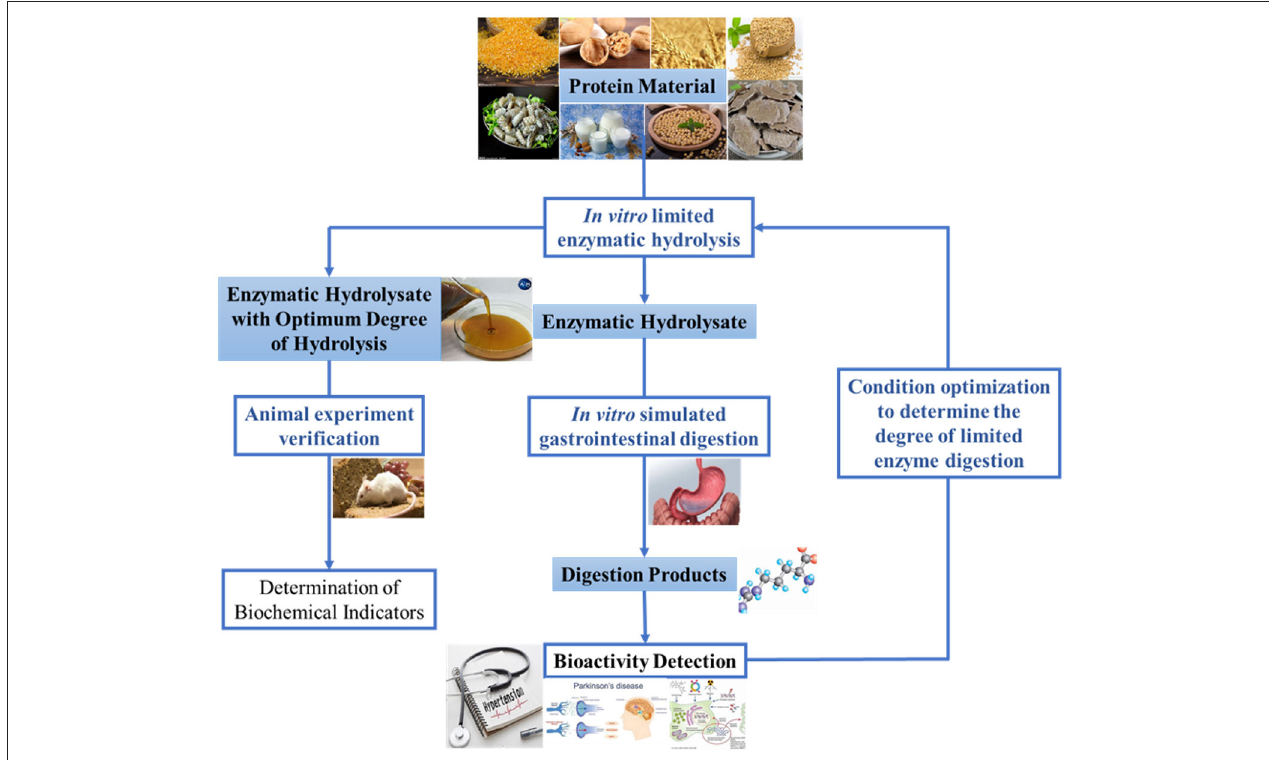
FIGURE 1 | Schematic representation of two-stages enzymatic hydrolysis method based on in vitro limited enzymatic hydrolysis and in vivo